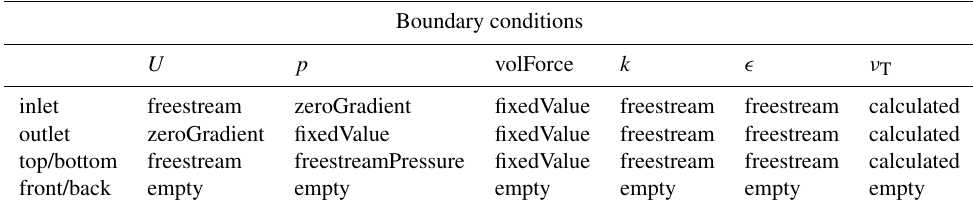
Table 1. Boundary conditions at time 0 for the computational